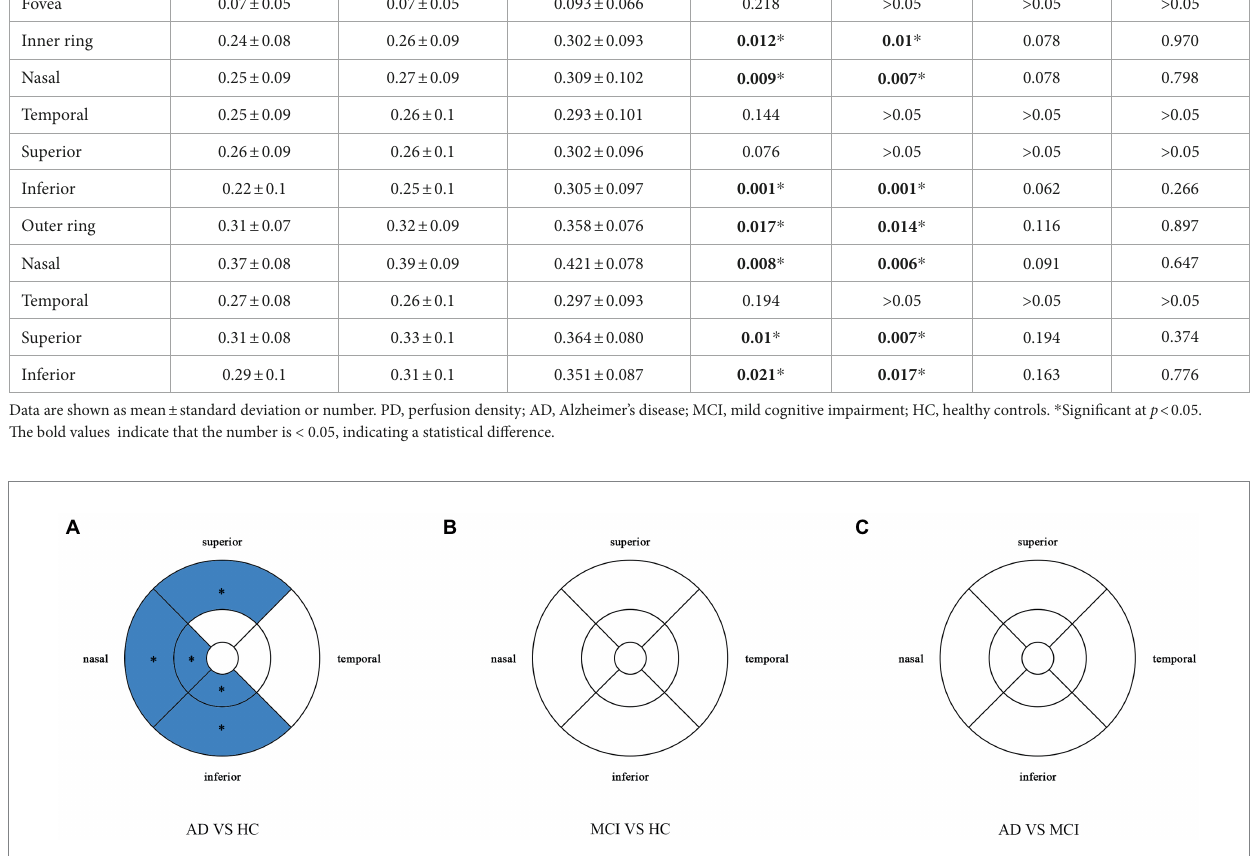
FIGURE 5 Comparison of perfusion density in macular among the AD, MCI, and HC groups. Blue regions indicate that the perfusion density of the former decreases significantly in these areas compared to the latter. (A) In the AD group, the perfusion density significantly reduces in the nasal and inferior regions of inner ring, and in the nasal, superior snd inferior regions of outer ring as compared to HC group. (B,C) There is no significant difference between MCI group and HC group, and between AD group and MCI group. *Significant at p < 0.05. AD, Alzheimer’s disease; MCI, mental cognitive impairment; HC, healthy